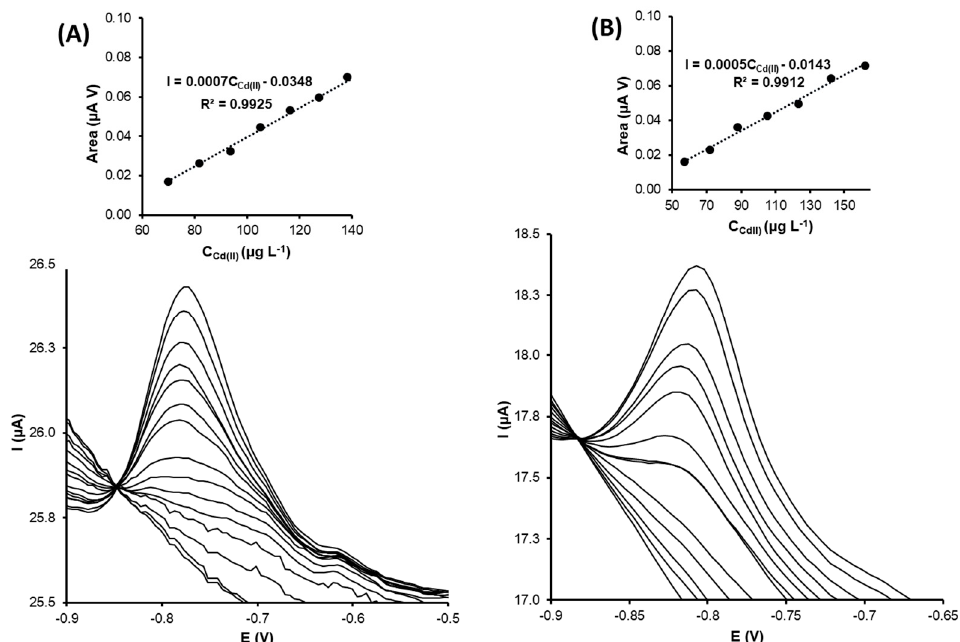
Figure 7. DPASV voltammograms for Cd(II) determination and its calibration curves (top inset) for ( A ) G-AgNPs-SPCNFE and ( B ) G-AuNPs-SPCNFE in acetic acid/acetate buffer 0.1 mol L − 1 pH 4.5 using an Ed of − 1.2 V and a td of 300 s.